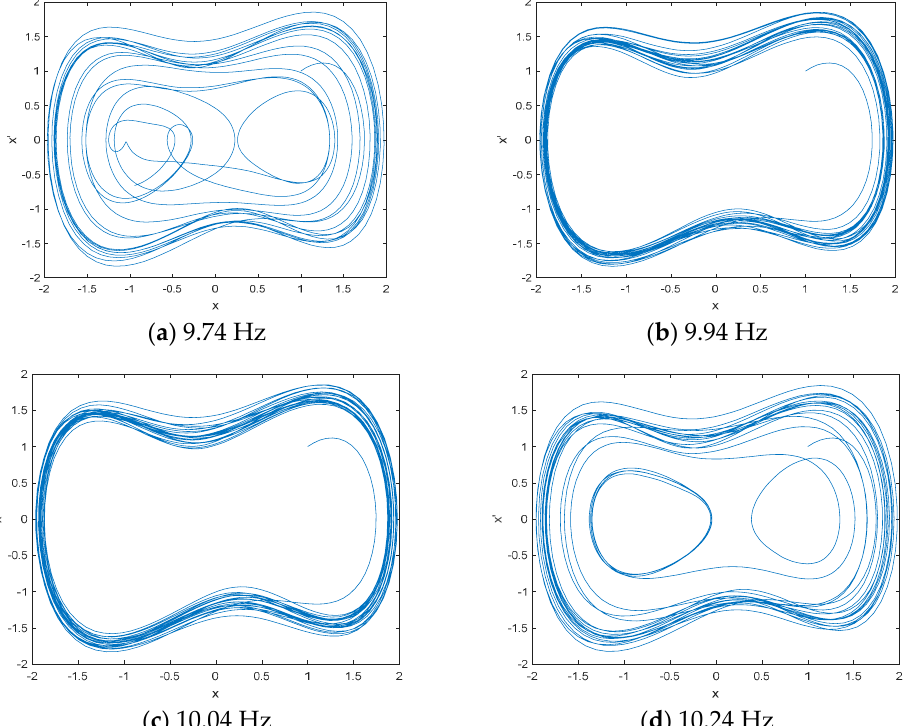
Figure 5. The phase space tracks of different driving force frequencies for IMF9.